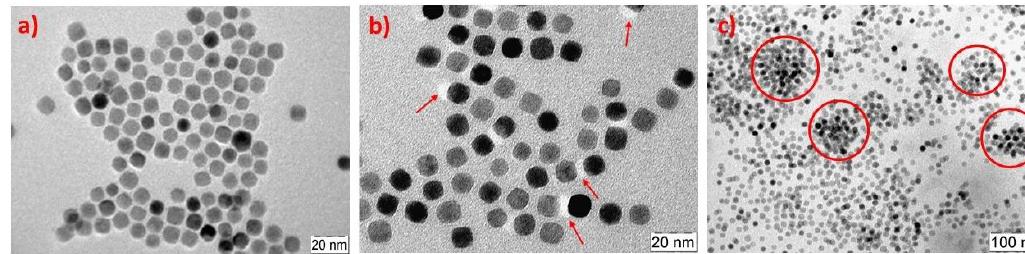
Figure 5. TEM images for ( a ) iron oxide NPs; ( b ) PLMA 22 - b -POEGMA 32 /10% NPs (red arrows indicate areas with a higher concentration of polymeric chains) and ( c ) PLMA 22 - b -POEGMA 13 /10% NPs mixed nanosystems after solvent evaporation (red circles indicate areas with large aggregation).